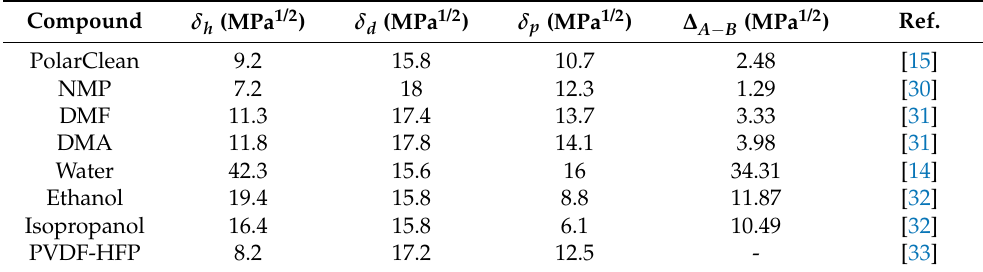
Table 3. HSPs, polymer-solvent and polymer/non-solvent solubility parameter ( ∆ A − B ).